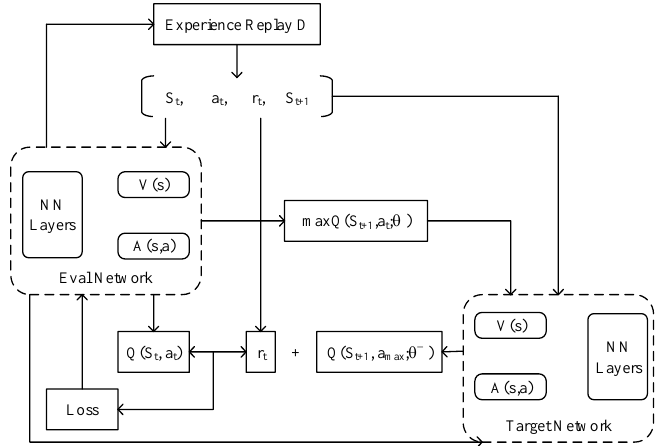
Figure 3. The process of P3DQN algorithm. P3DQN has two independent neural networks: the evaluation network and target network. The parameters are represented by q and q − , respectively. At t time, the agent executes action a in state r , and the next state is S , observes that the reward is t t t The 4-tuple is the experience P3DQN acquires from the environment. The 1 , , , t t t t S a r S + parameters of the evaluation network will be updated iteratively based on the acquired experience. At t time, its loss function can be expressed as Equation (12):